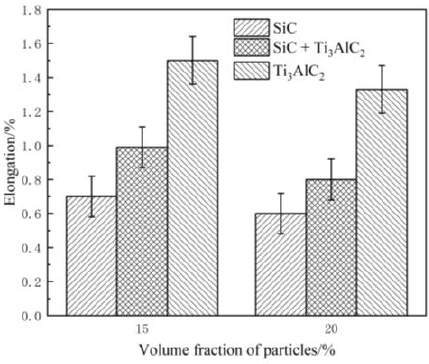
Figure 9. The elongation of the as-prepared samples.